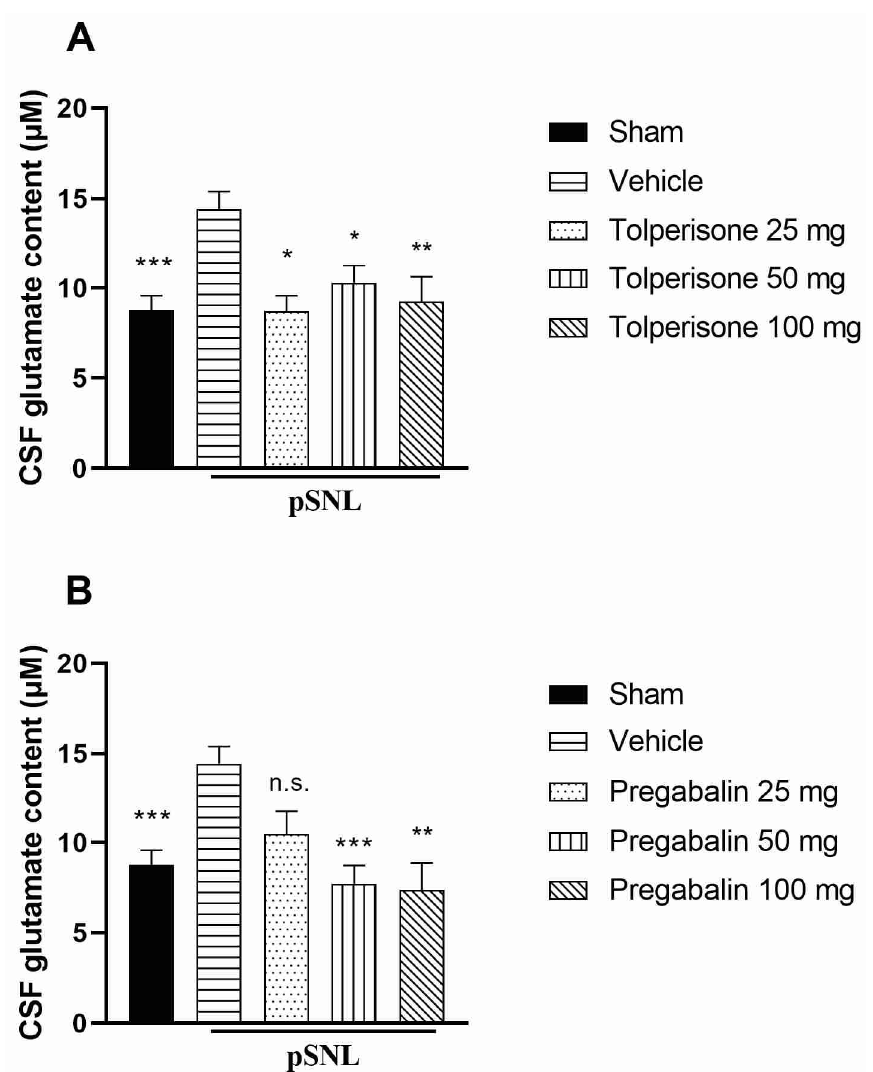
Figure 2. Glutamate content in CSF obtained from pSNL rats 14 days after surgery. Rats were treated with 25, 50, and 100 mg/kg dose of tolperisone ( A ) or pregabalin ( B ) per os or vehicle ( A , B ), and CSF samples were taken 3 h after treatment. Columns represent the mean of amino acid content ± S.E.M. in µ M in the indicated groups. Asterisks mark the significant differences compared to vehicle treated group (one-way ANOVA, F(4, 54) = 6.774 ( A ), F(4, 50) = 8.478 ( B ), Tukey post-hoc test; ***: p < 0.001; **: p < 0.01; *: p < 0.05; ns: non-significant). In each treatment group 6–18 animals were used.